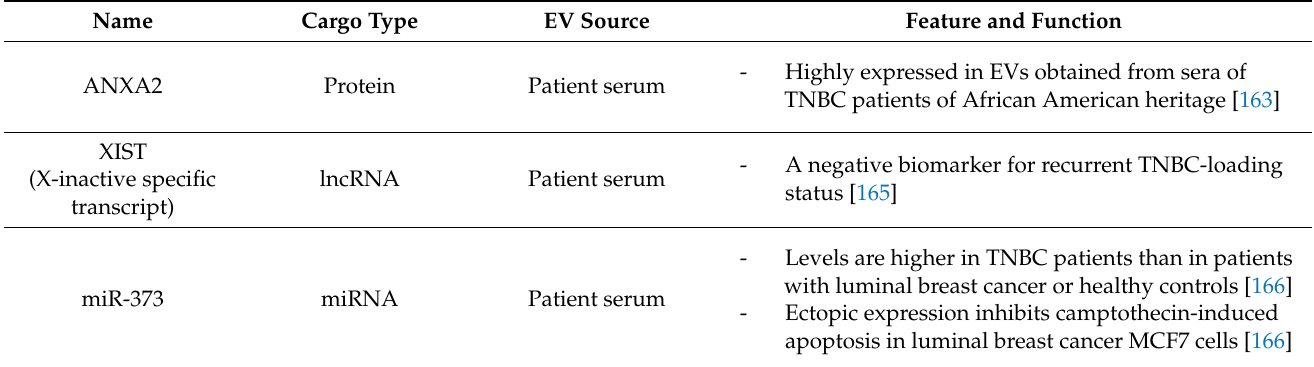
Table 4. TNBC-EV cargo components as